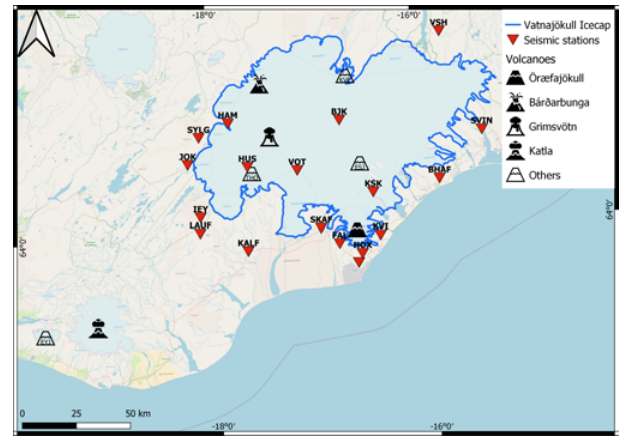
Figure 1: Map of the seismic stations used in this study, with the blue layout being the Vatnajokull icecap and with the major active volcanoes within this icecap. For the volcanoes included in “Others”, KVE stands for Kverkfjöll, ESJ stands for Esjufjöll, THO stands for Thor- darhyrna, and EYJ stands for Eyjafjallajökull.